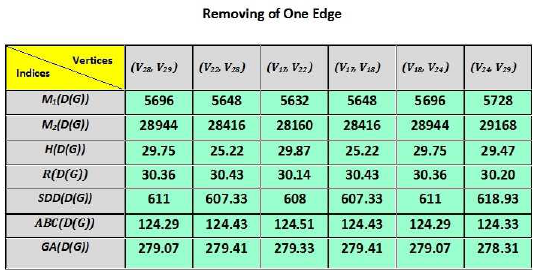
Fig. 4 Removing of one edge sets of healthy Liver